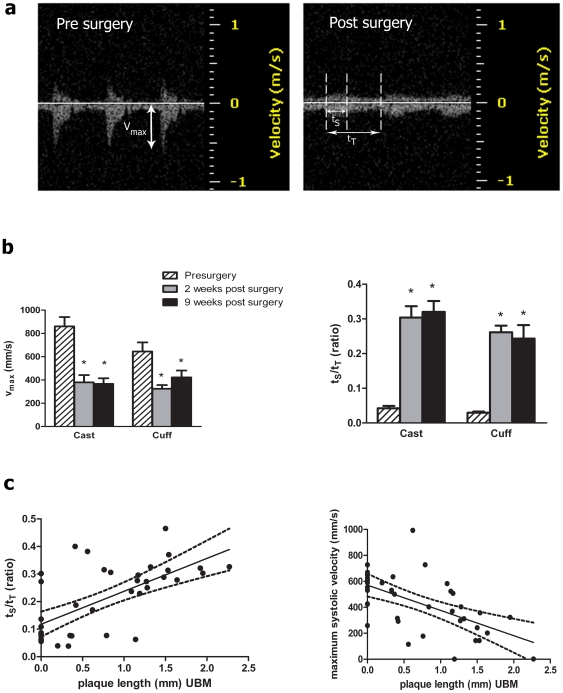
Pre-plaque PW-Doppler parameters correlate with plaque length at 9 weeks.(a) Representative PW-Doppler tracing of a proximal RCCA before and after surgery. Note the dramatic decrease in velocity. Measurements of vmax, time in systole (ts) and tT (total time) are indicated. (b) vmax and ts/tT were calculated from pre-surgery tracings and 2 and 9 weeks after device placement. Data (mean±SEM, n = 7 cuffs, 10 casts), were analyzed by 2 way ANOVA. There was a highly significant effect of device on vmax and ts/tT ratio (p<0.005), but no significant difference between cast and cuffs on either parameter. “*” p<0.05 compared to pre-surgery. (c) Using 39 animals fitted with casts, 2 week ts/tT and vmax values were calculated and plotted against plaque length at 9 weeks and the correlation determined by linear regression. ts/tT positively correlated with plaque length (p<0.0005, r = 0.66) between, vmax and plaque length were negatively correlated (p<0.0005, r = 0.59). Dotted lines indicate 95% confidence interval.